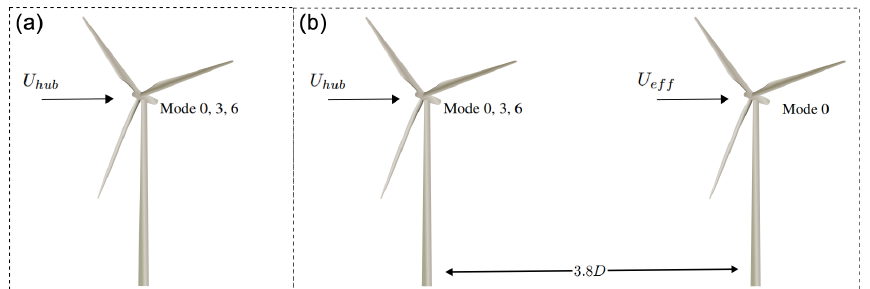
Figure 4. (a) Setup 1 with the downwind attenuation of sound from a single wind turbine at different operational modes. (b) Setup 2 with the downwind attenuation of sound from a single wind turbine in the wake of a wind turbine at different operational modes. The distance between the two wind turbines is d ≈ 3 . 8 D .